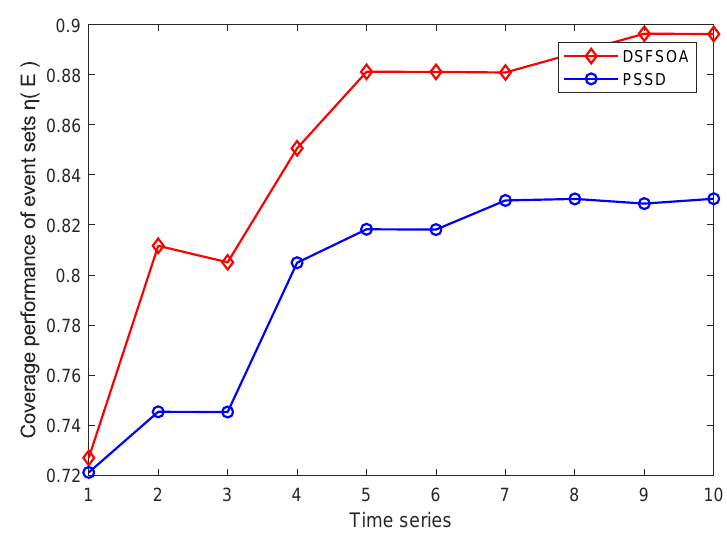
Figure 9. Comparison of the evolution of coverage efficacy at different times.